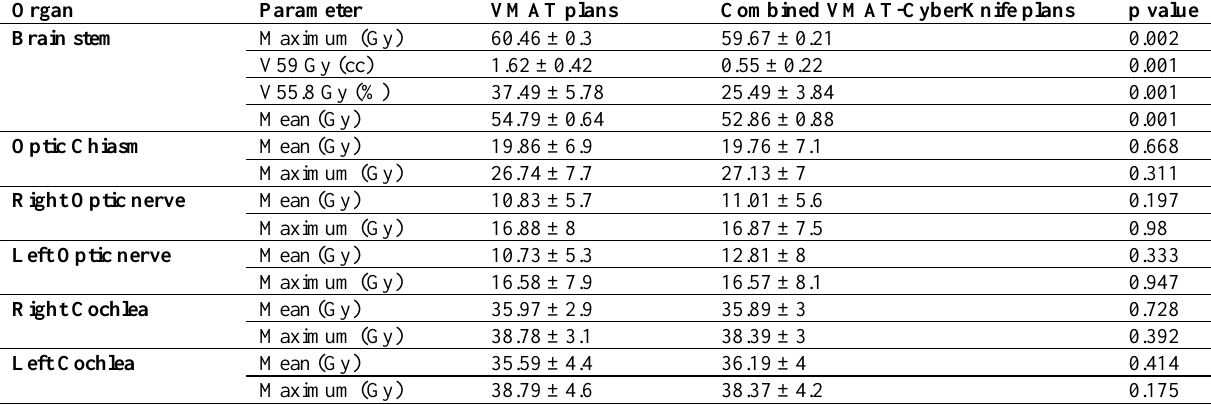
Table 2: Comparison of mean of doses calculated at organs at risk in both sum plans Organ